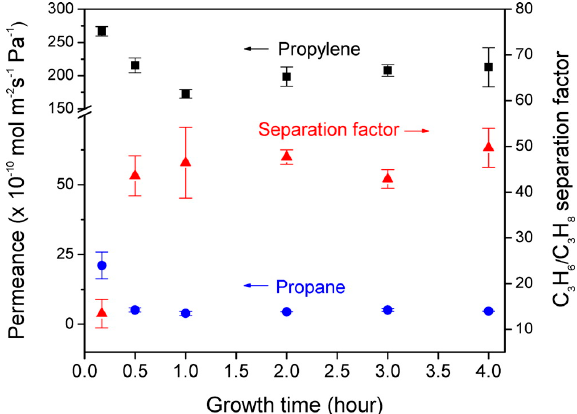
Figure 62. Permeances and separation factors at T = 298 K of the ZIF-8 membrane as shown in Figure 1 for ethene and ethane as pure component as well as in equimolar mixture for different feed pressures. The mixture measurements were carried out using the Wicke–Kallenbach technique (partial pressure of the C 2 component ≈ 0 at the permeate side) while for the single gas measurement no sweep gas was used (partial pressure of the C 2 component ≈ 1 bar at the permeate side). For gas mixtures, the permeances were calculated at T = 293.15 K and p = 1.013 bar from the applied partial pressure difference (for equimolar composition this is 1/2 feed pressure) and for pure component from the total pressure difference (p = 5 bar) (adapted with permission from ref. [145]).